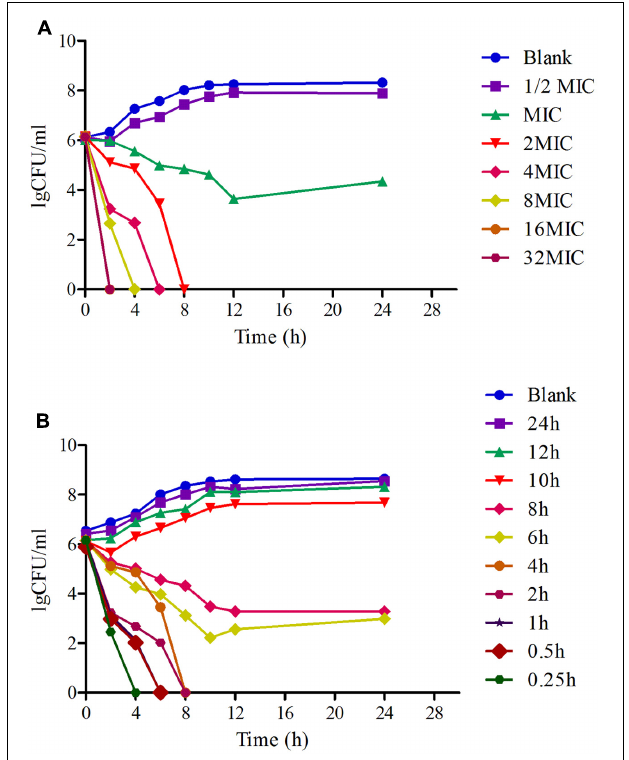
FIGURE 3 | The time-killing curves of MBF against E. coli in vitro (LB) and ex vivo (ileum content). (A) Presented the curve in vitro , (B) presented the curve in ex vivo